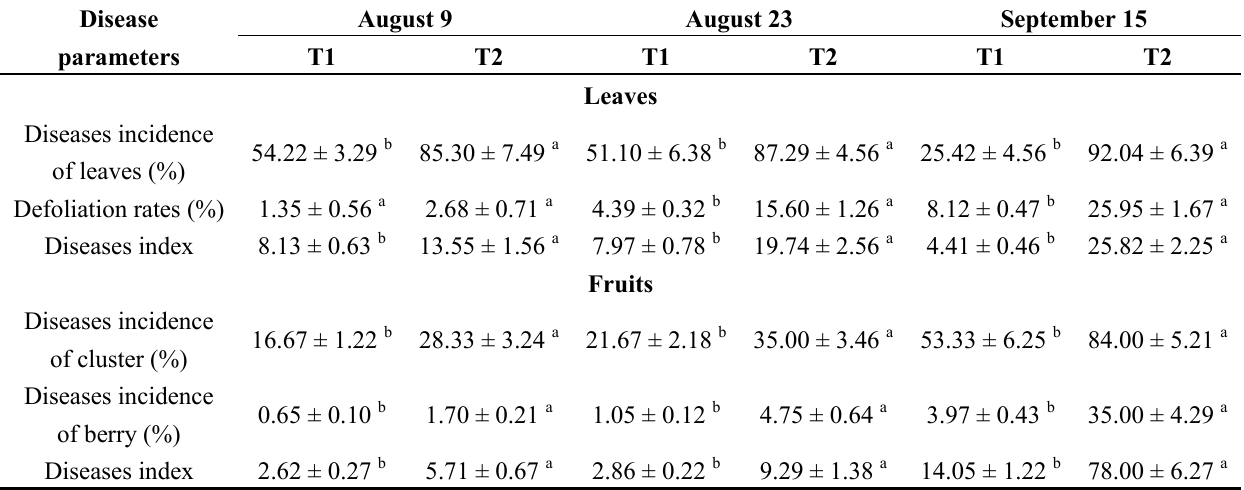
significantly different at the 0.05 level according to ANOVA by Duncan’s test. —, represent not analyzed. Table 2 is consistent with Table 1. Table 2. Diseases of grape leaves and fruits under rain-shelter cultivation (T1) and open-field cultivation (T2) during ripening in the 2011